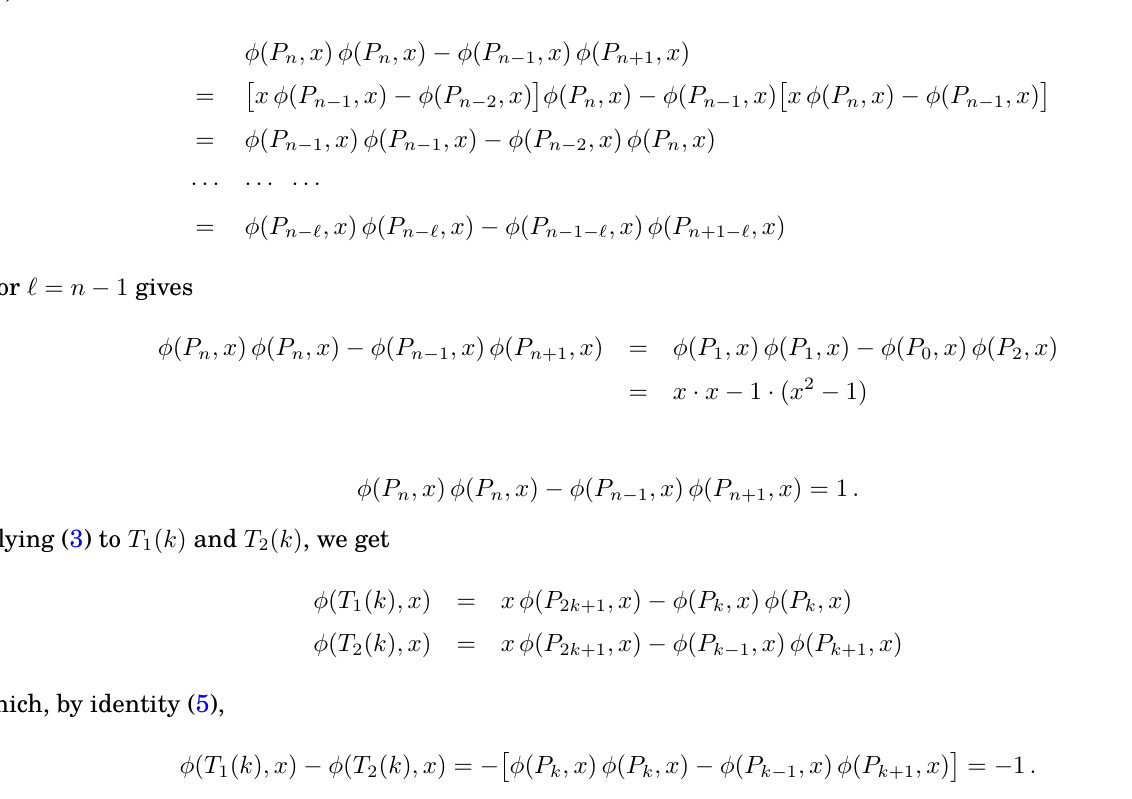
Figure 2: Two families of tree siblings. T 1 ( k ) and T 3 ( k ) are non-singular for k = 2 , 4 , 6 , . . . , in which case T 2 ( k ) and T 4 ( k ) are singular. For k = 1 , 3 , 5 , . . . , T 2 ( k ) and T 4 ( k ) are non-singular, whereas T 1 ( k ) and T 3 ( k ) are singular. From (4) it